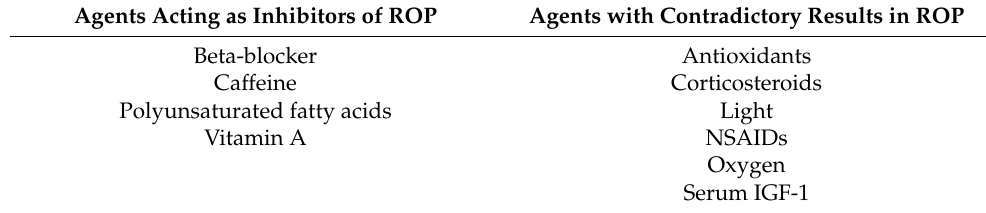
Table 2. The list of ROP therapies under investigation. Agents Acting as Inhibitors of ROP Agents with Contradictory Results in ROP Beta-blocker Antioxidants Caffeine Corticosteroids Polyunsaturated fatty acids Light Vitamin A NSAIDs Oxygen Serum